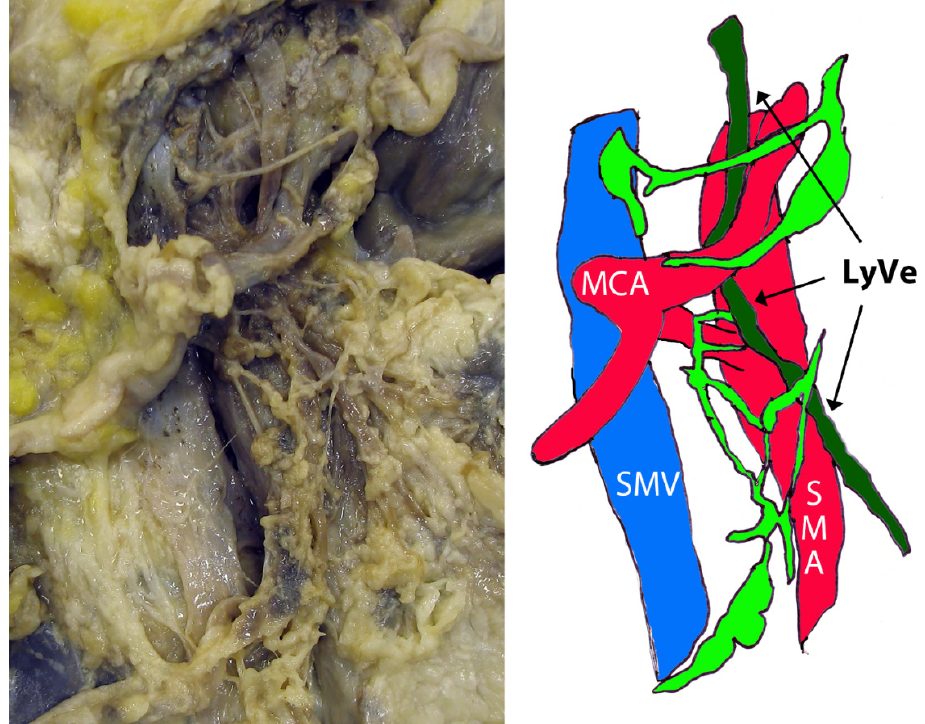
Figure 1. Dissection of the D3 volume and schematic presentation. The middle colic artery (MCA) is seen with its bifurcation. SMV—superior mesenteric vein; SMA—superior mesenteric artery; LyVe—large lymphatic vessel; light green—superficial lymph vessels and nodes. Table 2. Morphology and morphometry of visible lymph vessels in the D3